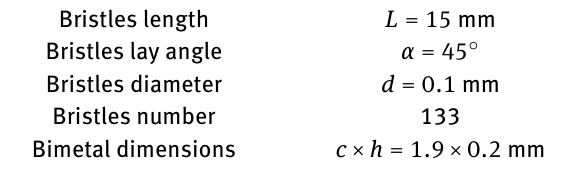
Table 1: Seal segent